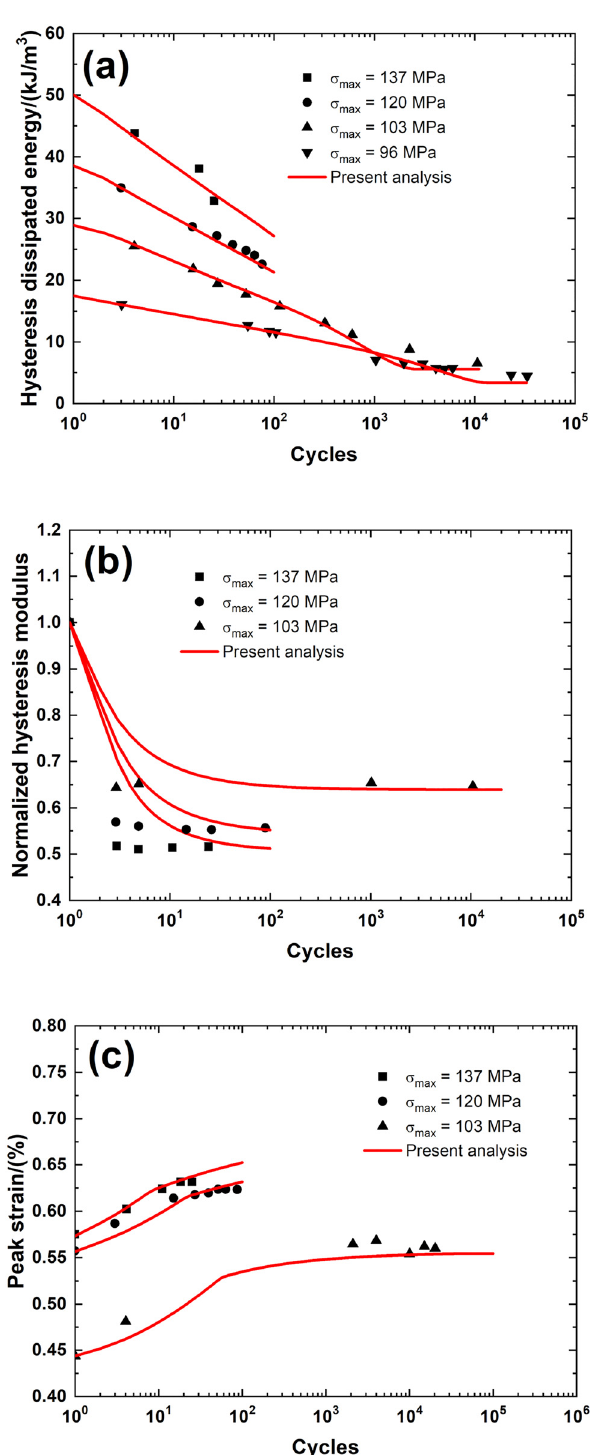
Figure 10: ( a ) The FHDE versus applied cycle curves, ( b ) the FHM versus applied cycle curves, and ( c ) the FPS versus applied cycle curves of cross - ply SiC/MAS composite under IF loading at 1,093°C in air